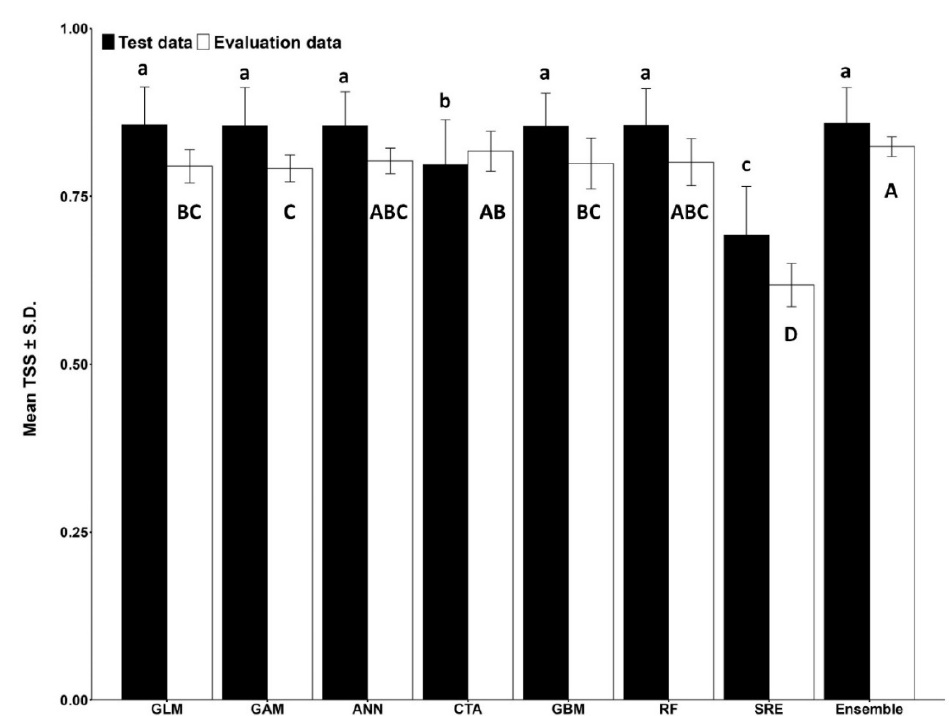
Figure 1. Mean TSS ( ± S.D.) scores of individual ( n = 30) and ensemble models ( n = 26) for predicting I. typographus presences using testing and evaluation data. GLM: generalized linear model, GAM: generalized additive model, ANN: artificial neural network, CTA: classification tree analysis, GBM: generalized boosting model, RF: random forest, SRE: surface range envelope. Bars with the same uppercase (white bars) or lowercase (black bars) letter are not significantly different according to multiple pairwise comparisons ( p < 0.05).